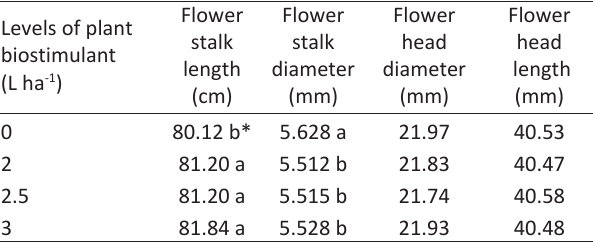
Table 2 - Residual effect of plant biostimulant on carnation flower quality Levels of